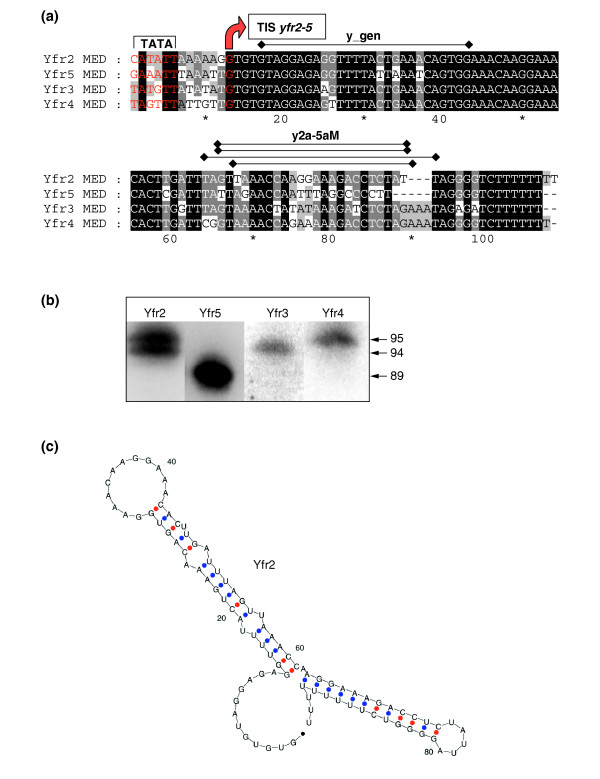
Comparison of Yfr2, Yfr3, Yfr4 and Yfr5 from MED4. (a) Sequence comparison of the yfr2 through yfr5 coding regions of MED4. Transcriptional initiation sites (TIS) and the deduced -10 elements are indicated. The location of specific oligonucleotide probes y2aM, y3aM, y4aM and y5aM used in Figure 5b and in 5' RACE and of the y_gen consensus probe used in Figure 4 is indicated by the lines with black diamonds on the ends on top of the alignment. (b) Signals for the four individual non-coding RNAs (ncRNAs) were detected in Northern blots using probes y2aM, y3aM, y4aM and y5aM. These probes have a minimum of five mismatches to their non-target ncRNAs, making cross-hybridizations impossible. The numbers indicate transcript lengths in nucleotides. (c) Prediction of secondary structure of MED4 Yfr2 by MFOLD [59].